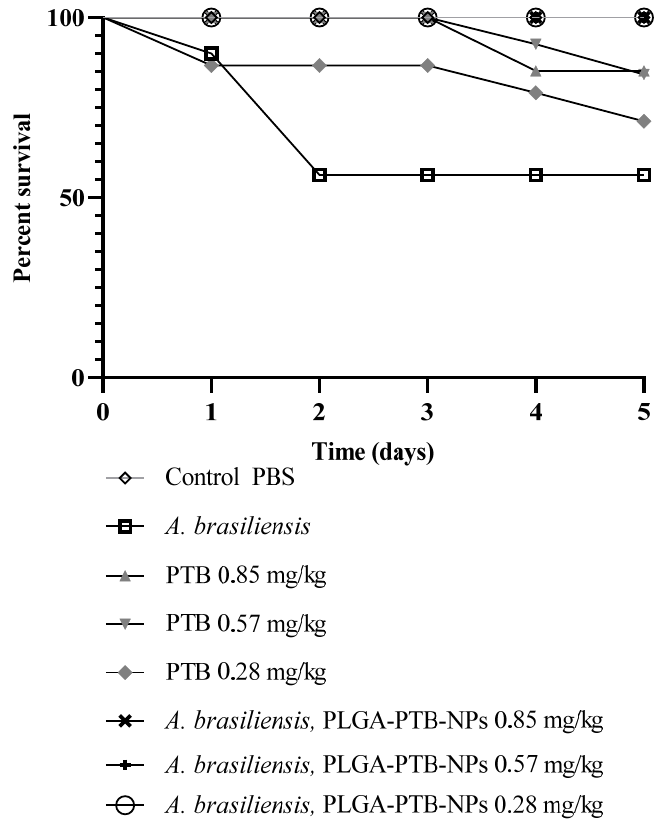
Figure 5. PLGA-PTB-NPs reduces A. brasiliensis virulence in G. mellonella model. Survival curves